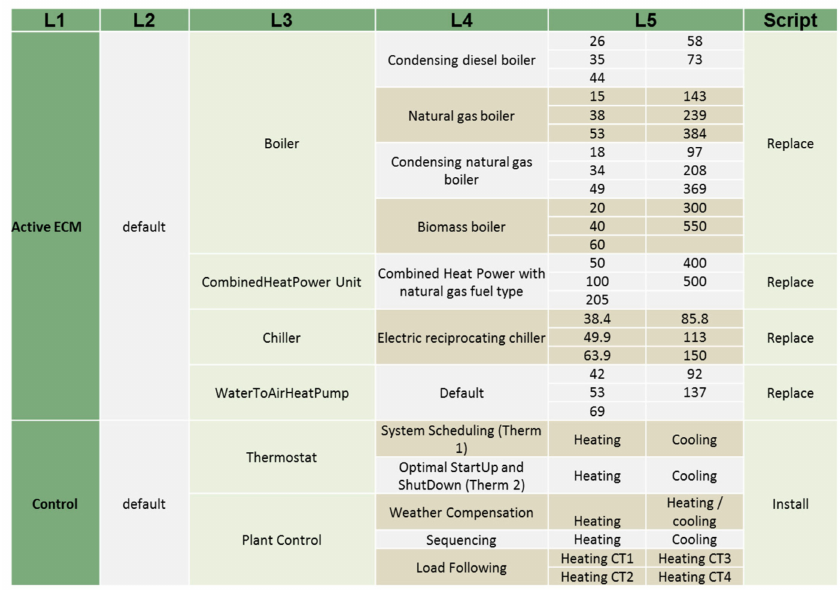
Figure 3. Example of Active and Control ECM